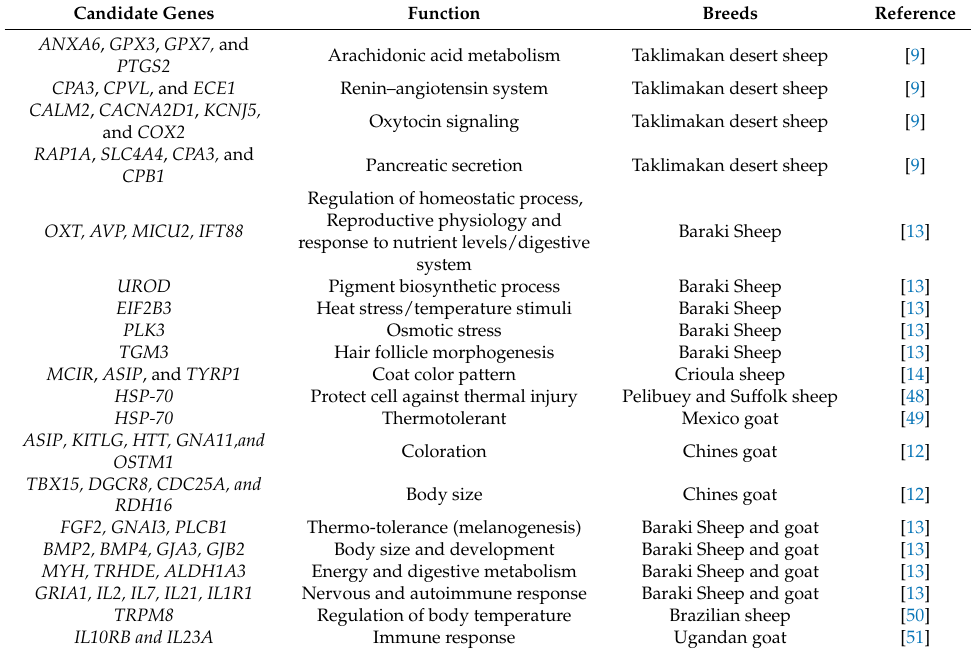
Table 2. Genes/candidate genes involved in heat